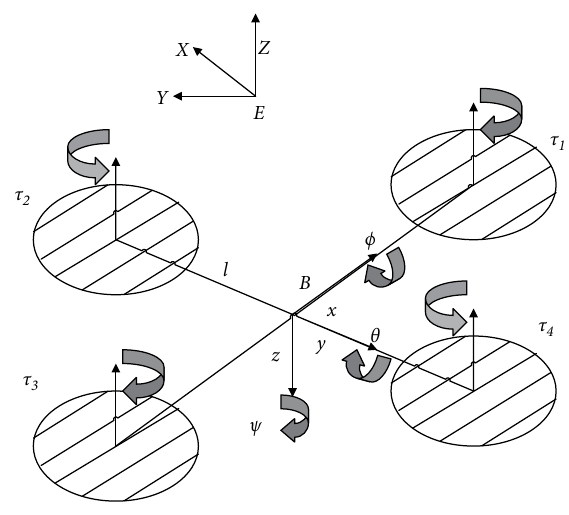
Figure 1: Model of quadrotor UAV